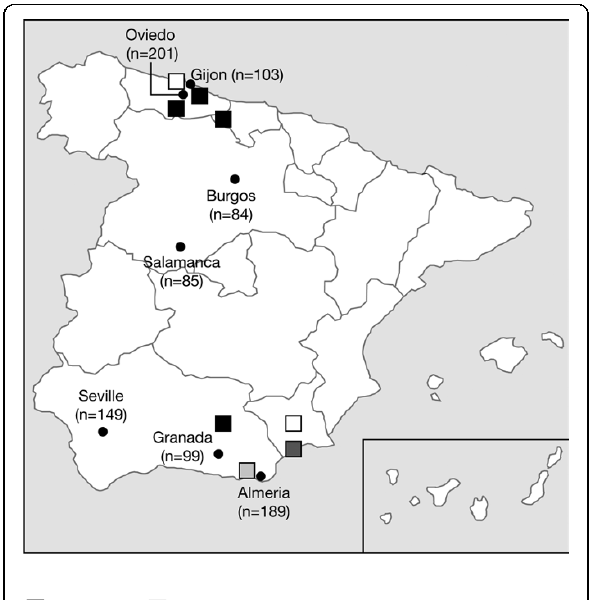
Figure 3 Location of participating centres and of patients with mutations that cause FD